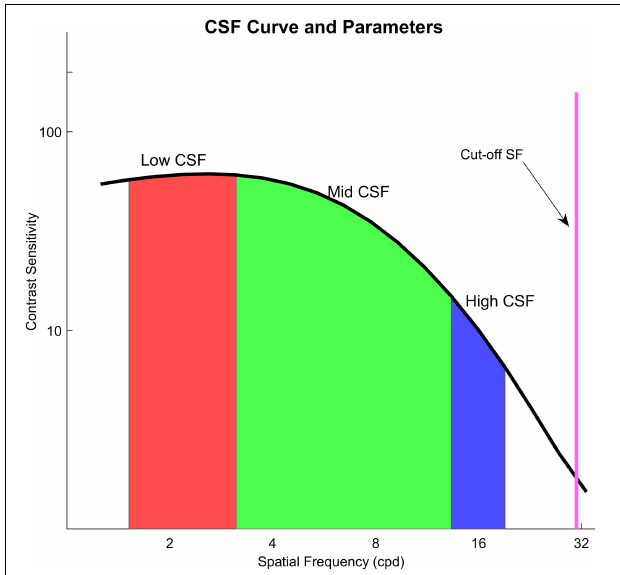
FIGURE 2 | The black curve in the figure is the contrast sensitivity curve; the red area means an area under low frequency (1.5–3 cpd) of the CSF curve (Low CSF); the green area means the area under middle frequency (3–12 cpd) of the CSF curve (Mid CSF); the blue area means the area under high spatial frequency (12–18 cpd) of the CSF curve (High CSF); the purple line shows Cut-off SF.